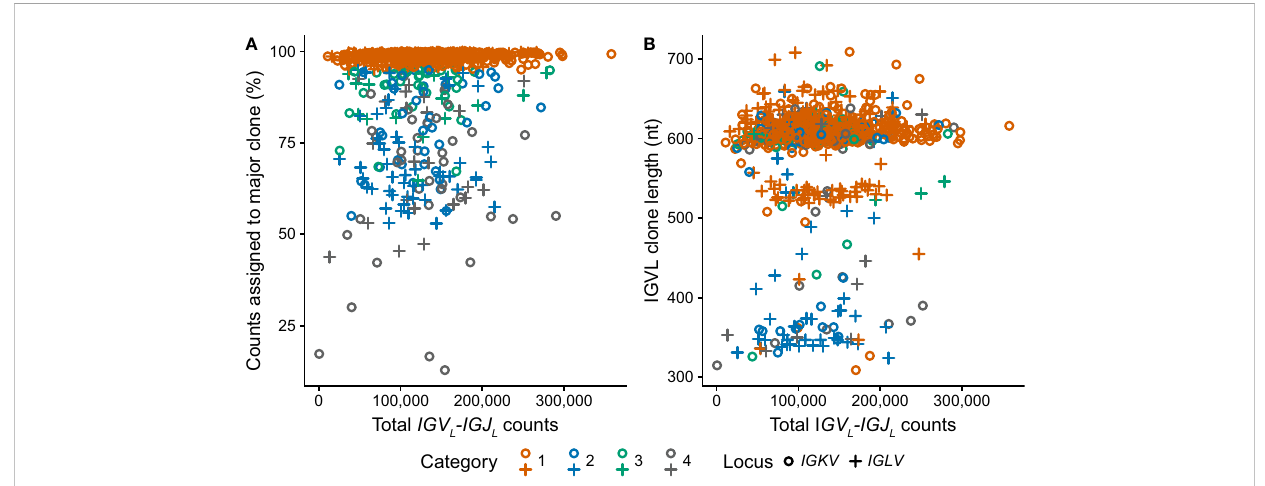
FIGURE 4 Clonal IGV L -IGJ L properties among 766 clinical samples are independent of the number of mapped reads. Fraction (A) and length (B) of the top IGV L -IGJ L clone are plotted against the total number of reads aligned to the IGK and IGL loci by MiXCR. Samples where the most frequent clone is derived from IGKV or IGLV are shown as circles and crosses, respectively. The category to which each clone was assigned is shown by the color of the symbol. For cases where the output from MiXCR comprised multiple non-contiguous segments for a single clonotype, only the longest segment was considered.